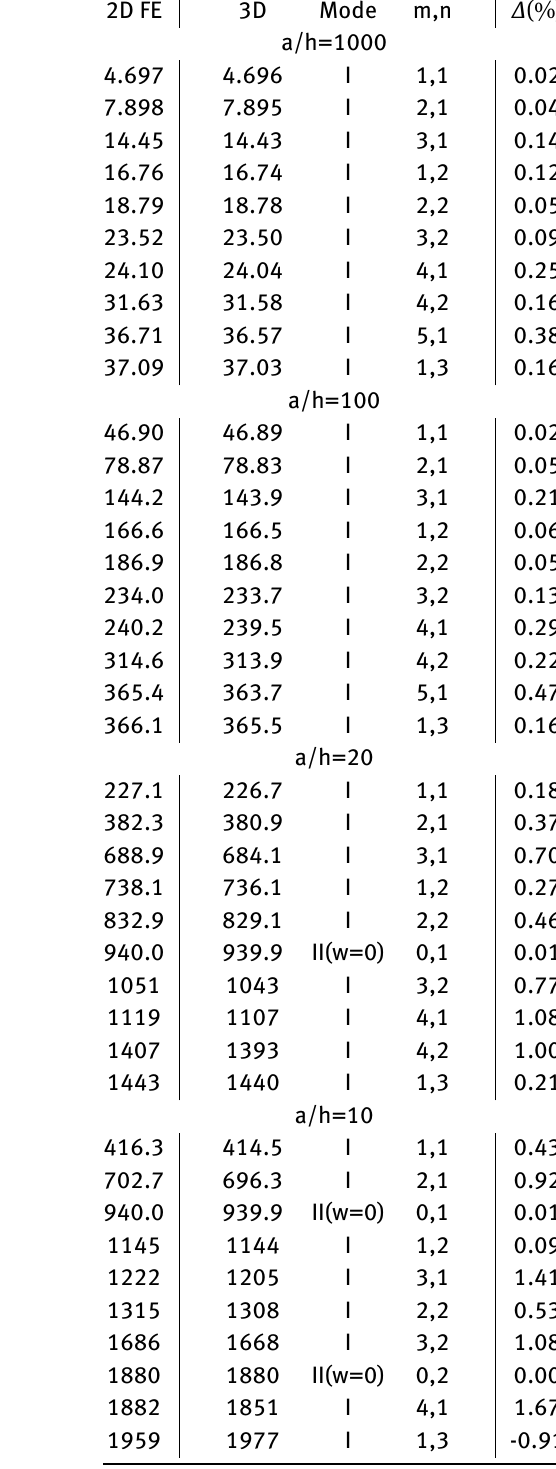
Table 13: Sixth benchmark, simply supported cylinder made of aluminium alloy, titanium alloy and steel with thickness ratios R α /h=1000, R α /h=100, R α / h = 10 and R α /h=5. First ten fre- quencies in Hz, comparison between the present 3D exact solu- tion and the 2D FE solution via Nastran. The error is calculated as ∆ (%) = FE −3 D × 100 . 3 D